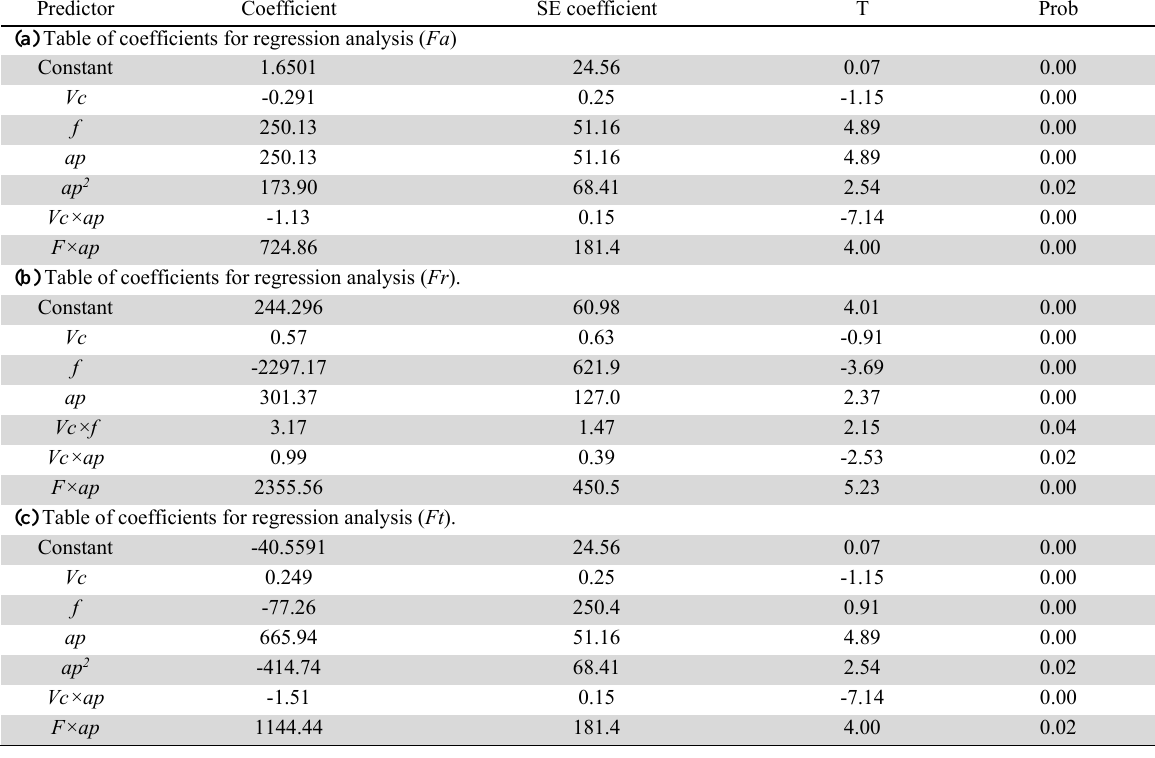
Table of coefficients for regression analysis, Response (a) Fa , (b) Fr , and (c) Ft. Predictor Coefficient SE coefficient T Prob (a) Table of coefficients for regression analysis ( Fa ) Constant